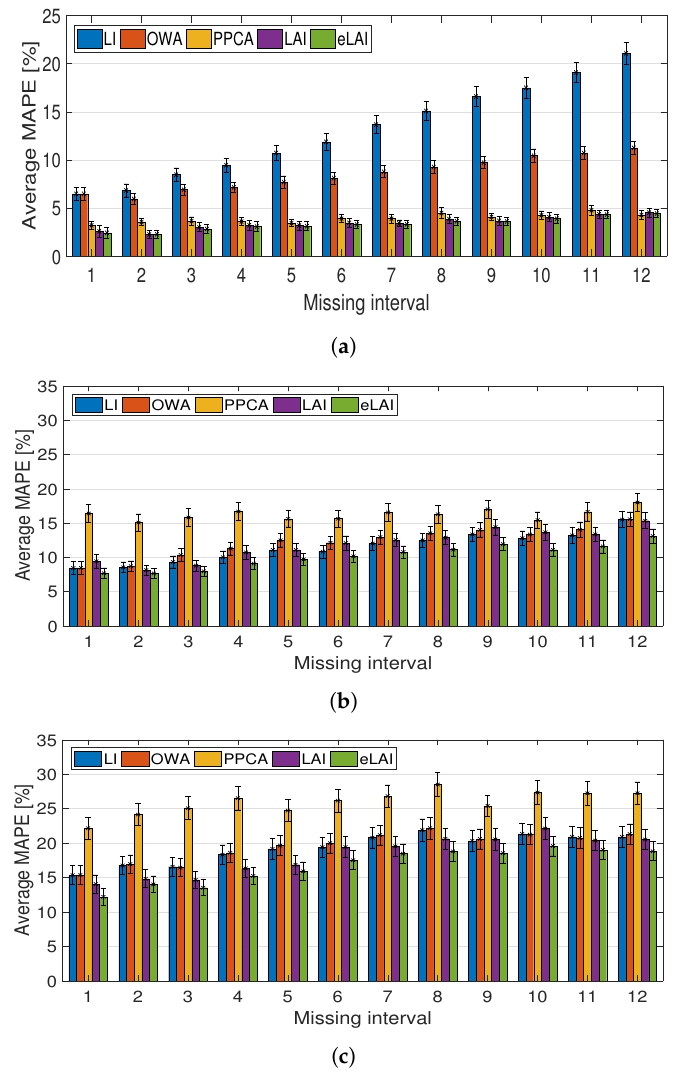
Figure 8. Average MAPE and 95% confidence interval of each method. ( a ) DOE; ( b ) KEPCO-high voltage; ( c ) KEPCO-low voltage.